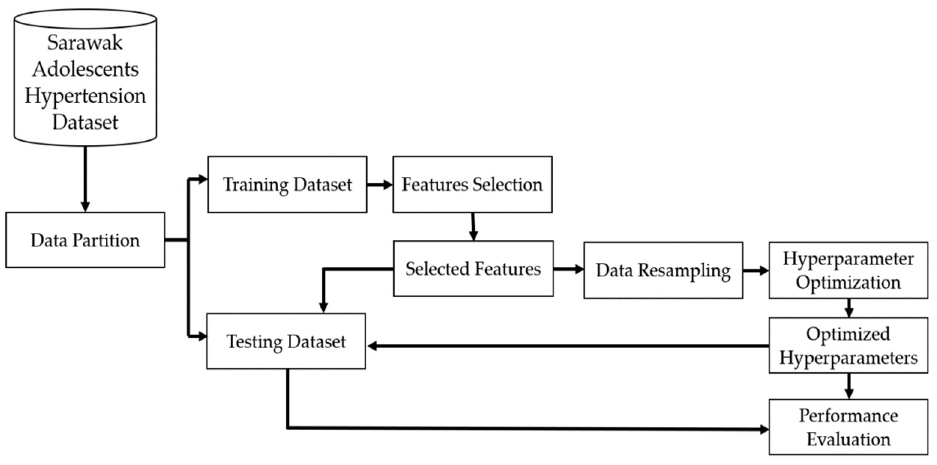
Figure 1. Overall processes involved in the study.